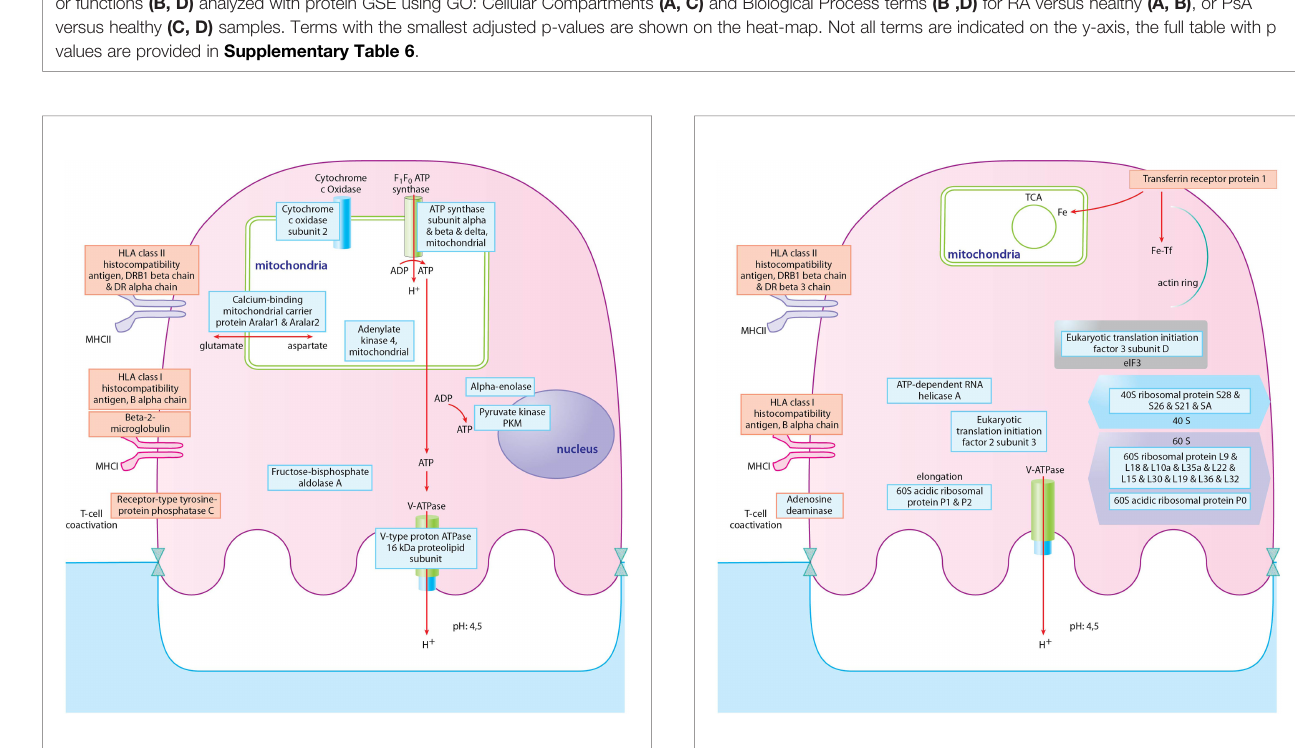
FIGURE 9 | Depiction of proteins signi fi cantly expressed in osteoclasts of PsA donors. Proteins with blue frame represent proteins of cytoplasmic translation pathway, proteins with red frame represent proteins of positive regulation of adaptive immune response pathway. Blue fi lling shows downregulation of proteins in PsA osteoclast samples compared to healthy ones, red fi lling shows upregulation of